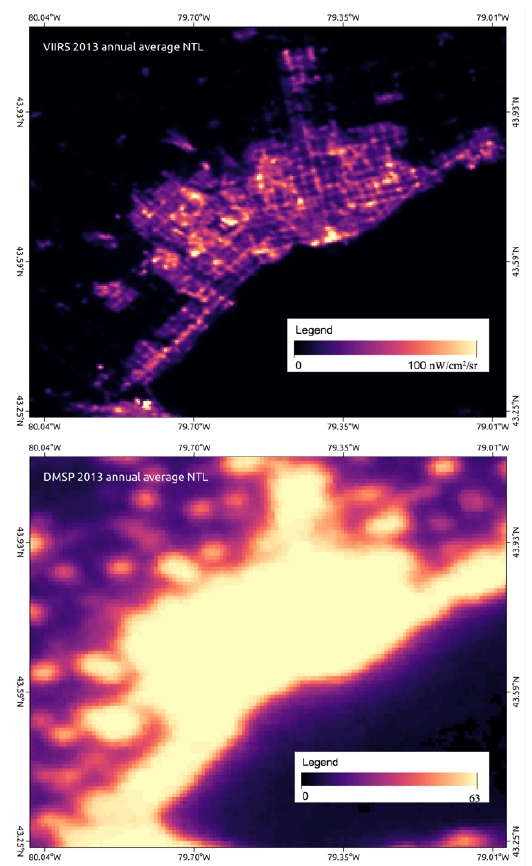
Figure 1. A comparison example of DMSP and VIIRS NTL data within the same